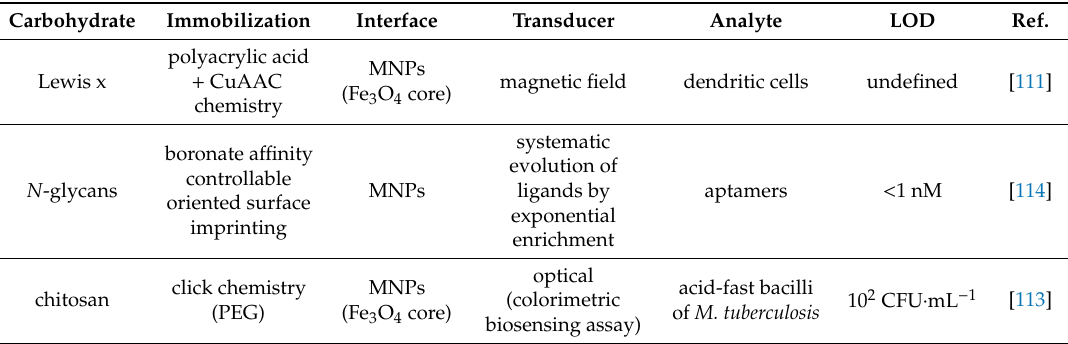
Table 3. MNPs-based glycan nanobiosensors and their characteristics.